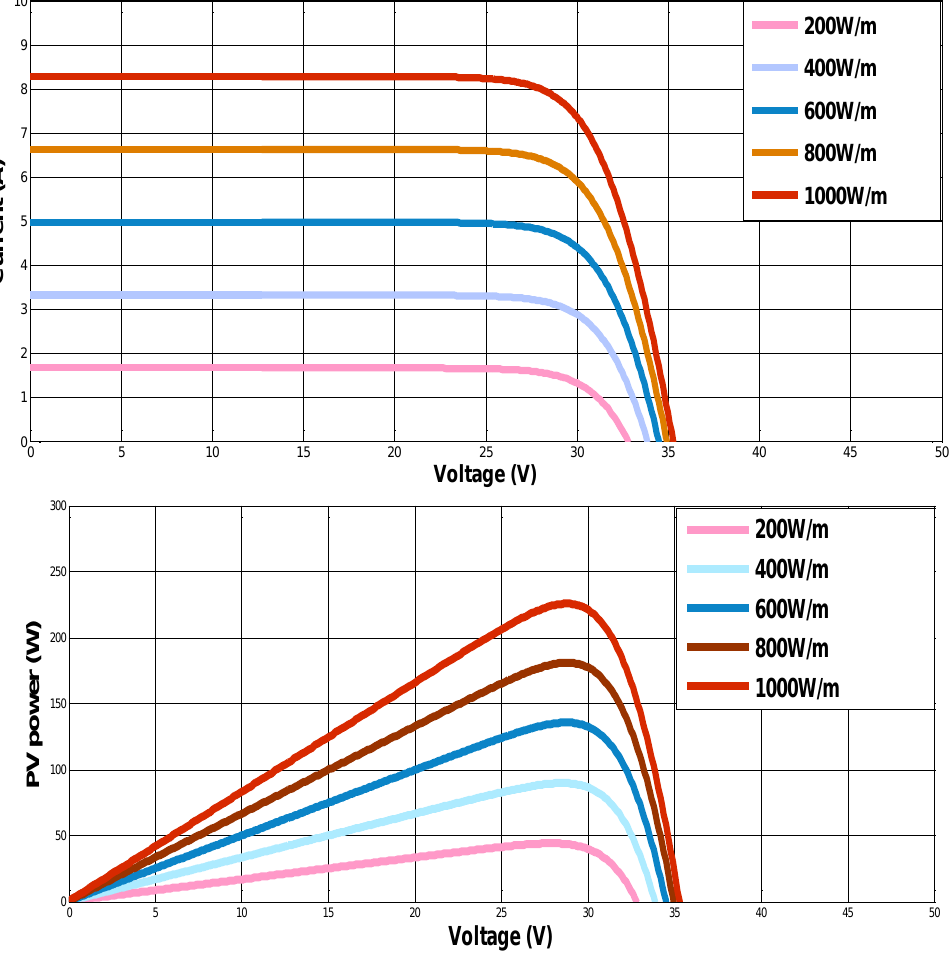
Figure 8. Electrical characteristics of the Sunmodule SW 250 mono panel for different solar irradiations.